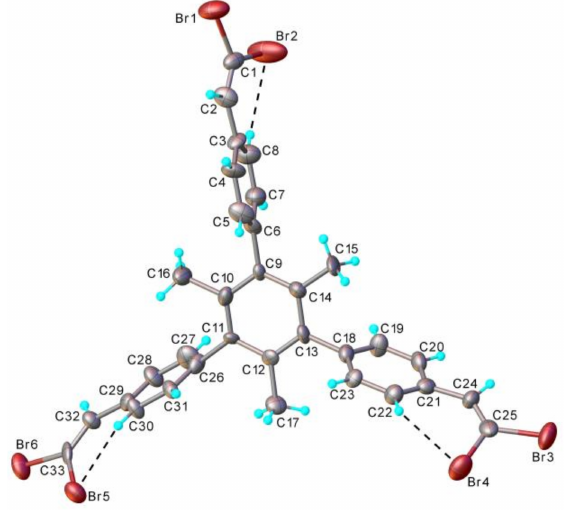
Figure 2. X-ray molecular structure of 9 with atom labeling and thermal ellipsoids at 40% level. H-bonds parameters: C8-H ··· Br2 [C8-H 0.93 Å, H ··· Br2 2.71 Å, C8 ··· Br2 3.336(6) Å, ∠ C8HBr2 125.3 ◦ ]; C22-H ··· Br4 [C22-H 0.93 Å, H ··· Br4 2.68 Å, C22 ··· Br4 3.337(6) Å, ∠ C22HBr4 128.4 ◦ ]; C30-H ··· Br5